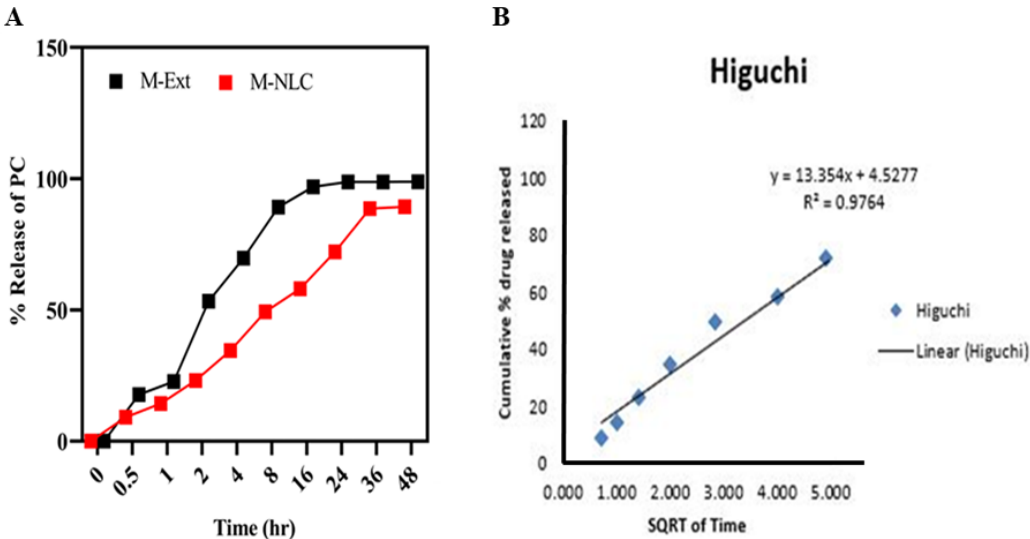
Figure 9. Ex vivo diffusion model. Ex vivo diffusion studies were performed on rat skin. ( A ) diffu- sion and release kinetics through rat skin. ( B ) Higuchi model. Data shown as means ± SD ( n =